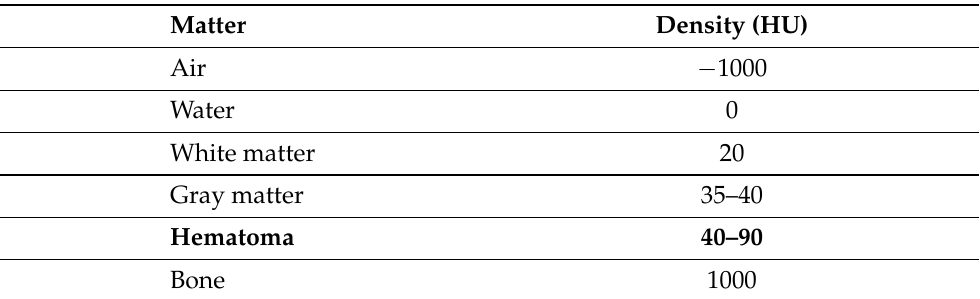
Table 3. HU density on CT/MRI